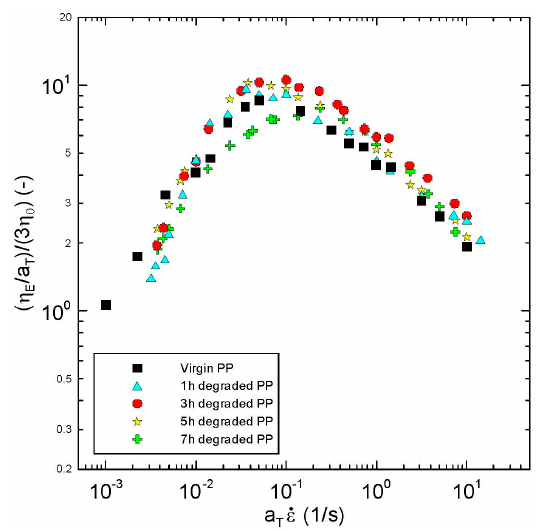
Figure 8. Steady-state extensional viscosity data at 180 °C normalized by the three-fold Newtonian viscosity for virgin and thermally degraded branched polypropylenes.